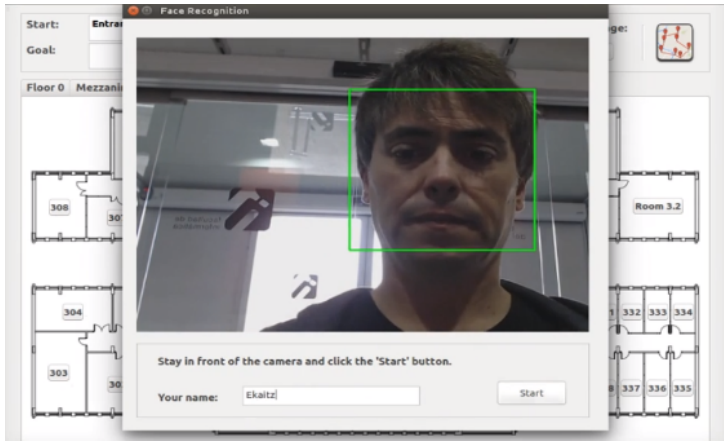
Figure 10. Window displayed to captured user’s image when the goal requires a floor